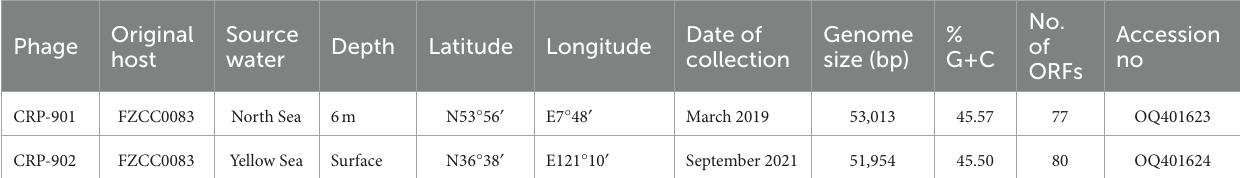
TABLE 1 General features of the two CHAB-I-5 phages analyzed in this study.